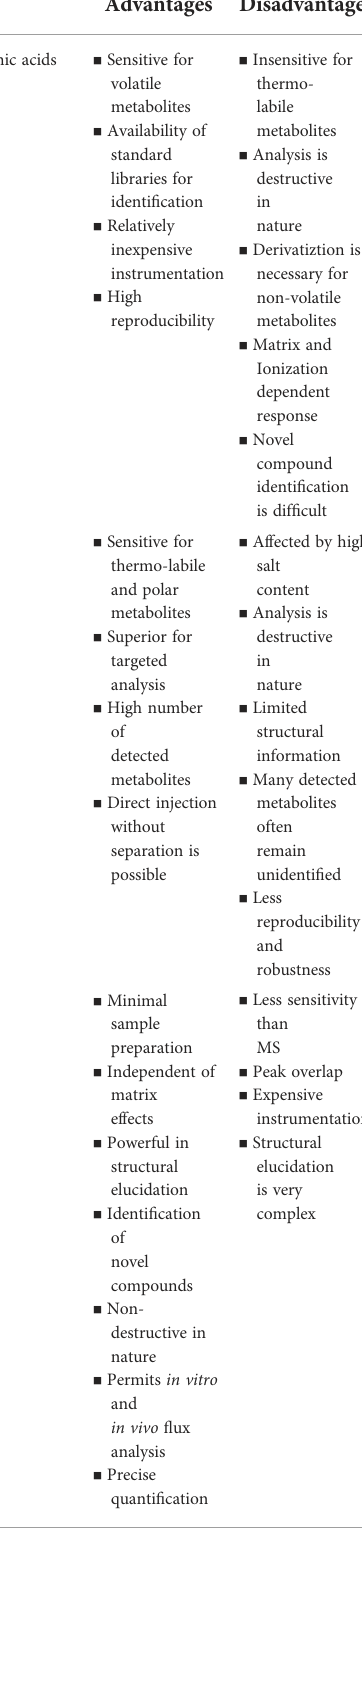
TABLE 1 The key differences between the most frequently used techniques in plant